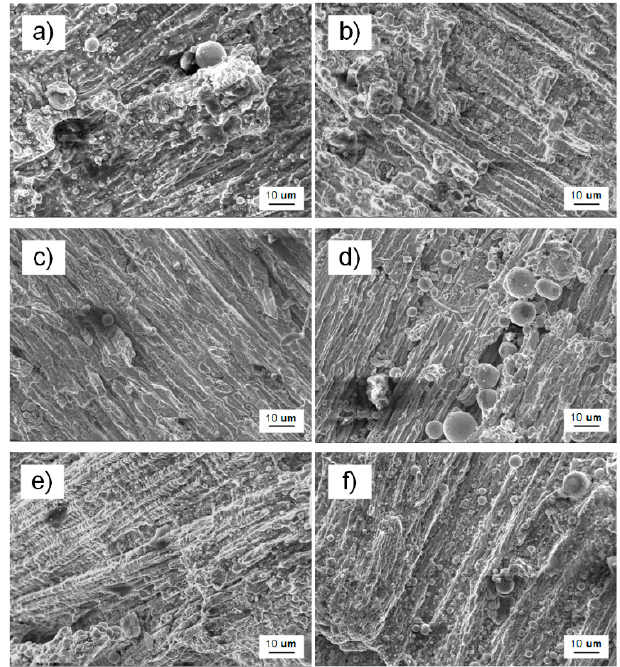
Figure 9. SEM micro-morphology fracture surface of tensile specimen ( a , b ) for specimen 1; ( c , d ) for specimen 2; and, ( e , f ) for specimen 3; steel on the left and copper on the right.